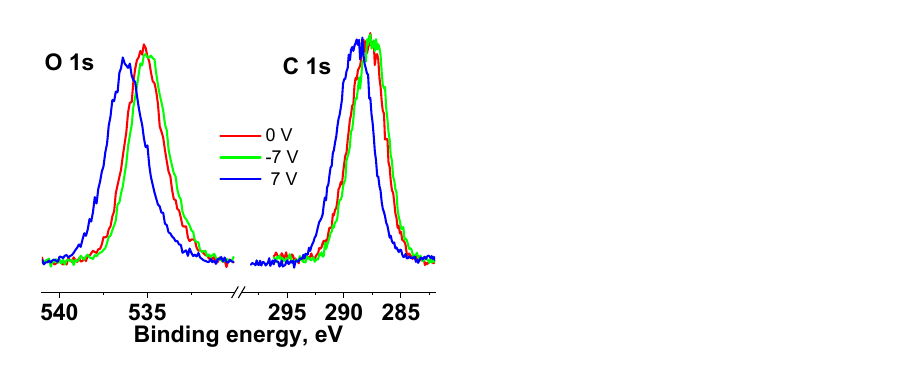
Figure 10. XPS C 1s and O 1s spectra of the cotton sample measured at different U b , the spectra are normalized by an area under the peak.